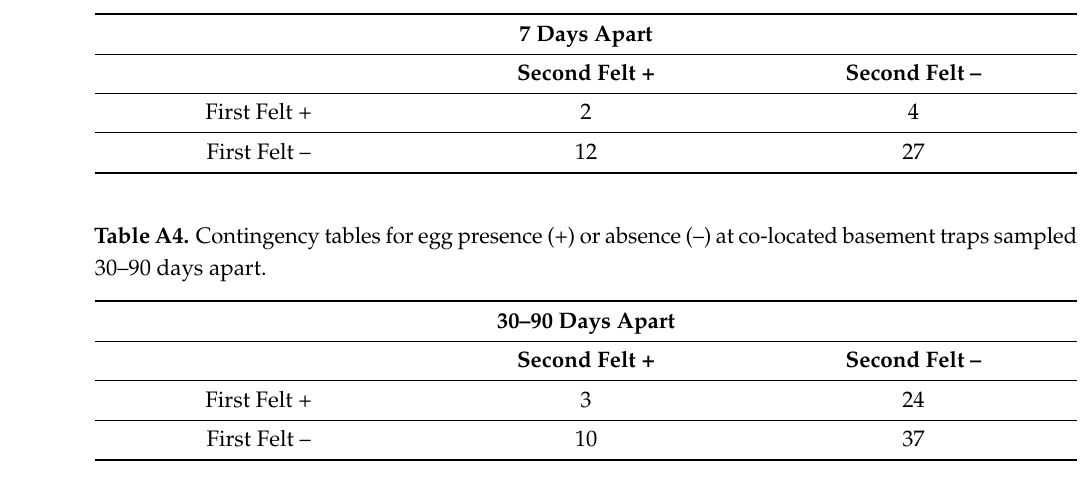
Table A3. Contingency tables for egg presence (+) or absence (–) at co-located basement traps sampled 7 days apart.